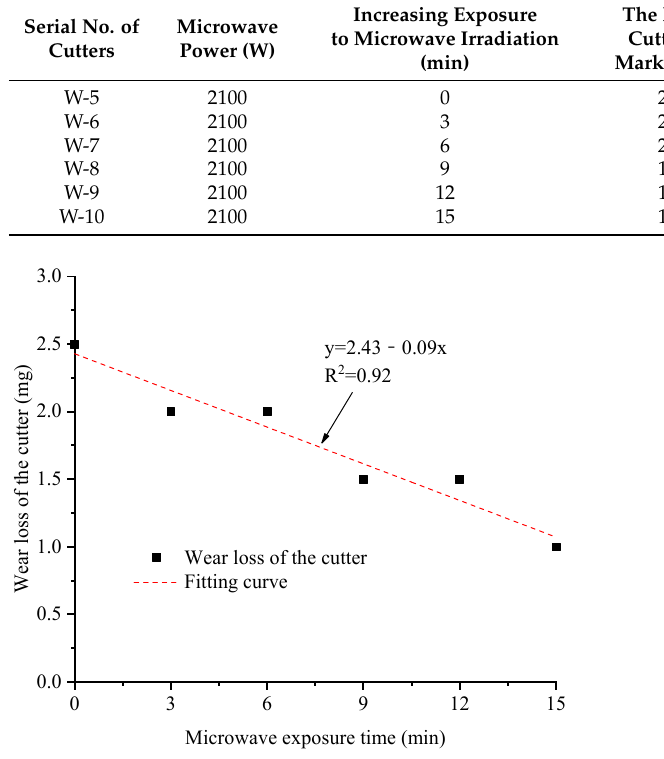
Figure 8. Changes in the average mass loss of the reduced-scale TBM cutter with increasing exposure to microwave irradiation .